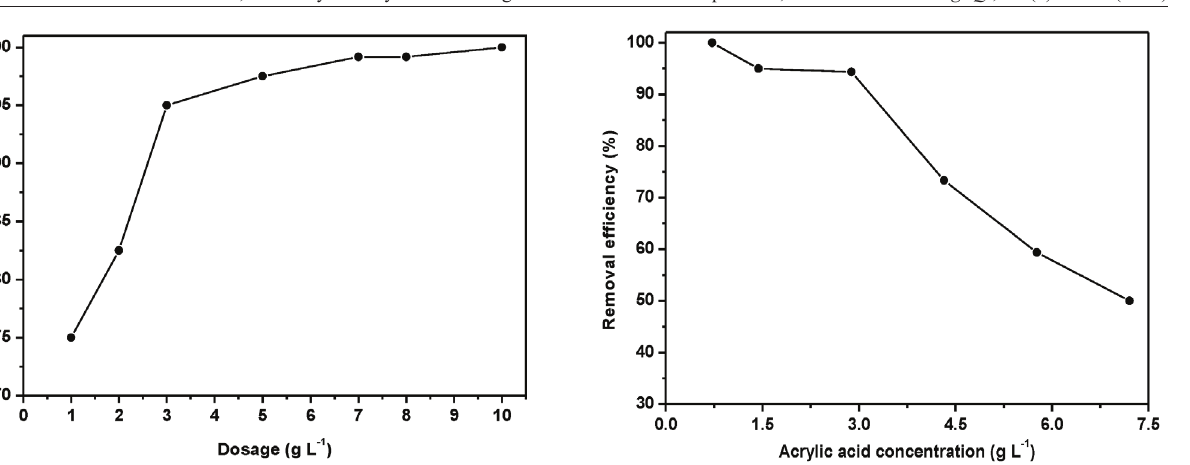
Fig. 6 – Effect of initial concentration on the removal effi- ciency of acrylic acid onto CaO